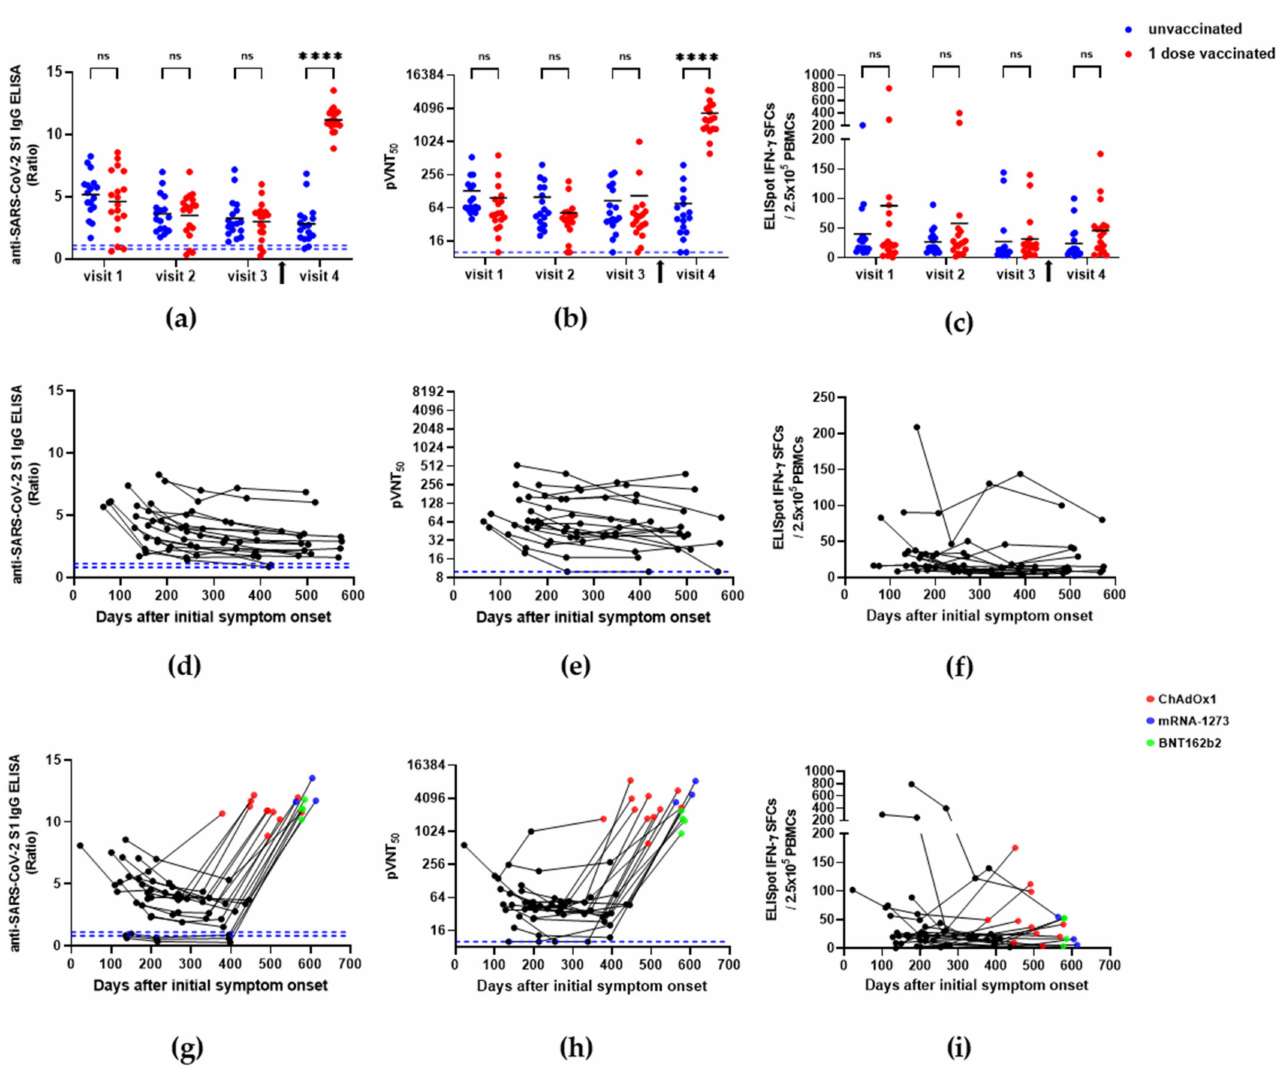
Figure 1. Humoral and cellular immune responses in SARS-CoV-2-recovered individuals. ( a ) SARS- CoV-2 S1 IgG ELISA ratio; ( b ) pVNT 50 titer; ( c ) IFN- γ ELISpot counts from visit one to visit four for unvaccinated and vaccinated individuals. The arrow indicates the vaccination time in the single- dose-vaccinated group. ( d ) SARS-CoV-2 S1 IgG ELISA ratio; ( e ) pVNT 50 titer; ( f ) IFN- γ ELISpot counts from visit one to visit four in unvaccinated individuals from the longitudinal study. ( g ) SARS- CoV-2 S1 IgG ELISA ratio; ( h ) pVNT 50 titer; ( i ) IFN- γ ELISpot counts from visit one to visit four in single-dose-vaccinated individuals from the longitudinal study. The blue dashed line indicates the cutoff (S1-IgG = 0.8 for negative and 1.1 for positive, pVNT 50 = 10). The significance of the differences between the unvaccinated and single-dose-vaccinated groups was determined using two-way ANOVA by Holm–Š í d á k’s multiple comparisons test. ns, p > 0.05, **** p < 0.0001. The anti-SARS-CoV-2 nucleocapsid antibody titer evaluated in all the SARS-CoV- 2-naïve individuals tested negative, suggesting that no previously infected individuals were included in the study (Supplementary Table S1). After COVID-19 vaccination, hu- moral immunity against SARS-CoV-2 was significantly increased in all vaccine groups except Ad26.CoV2.S (Figure 3). The S1-IgG antibody titer was the highest in mRNA- 1273 (11.3 ± 1.0), followed by BNT162b2 (10.2 ± 1.2), ChAdOX1/BNT162b2 combina- tion (8.0 ± 1.3), ChAdOX1 (5.6 ± 2.7), and Ad26.CoV2.S (1.4 ± 0.8) (Table 5). pVNT